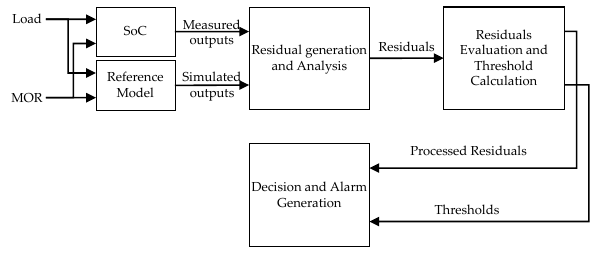
Figure 3. Overview of the proposed monitoring